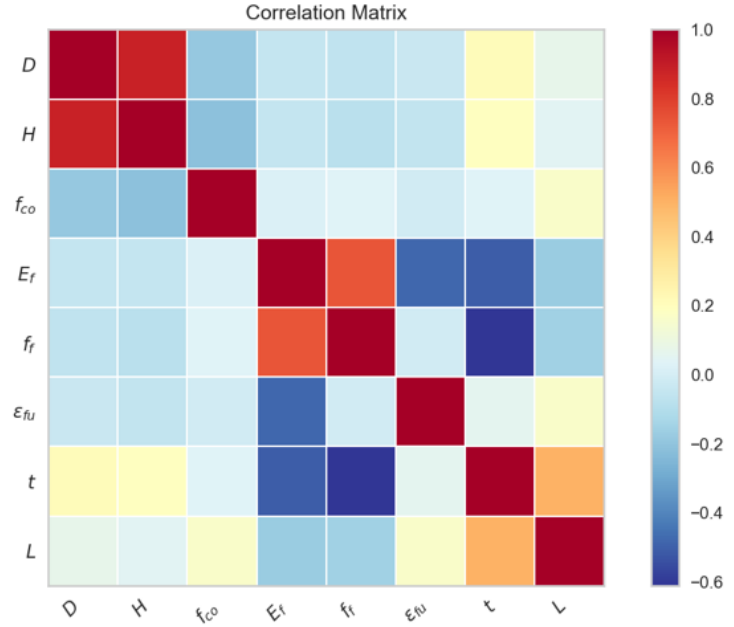
Figure 3. Correlation matrix for the eight inputs.